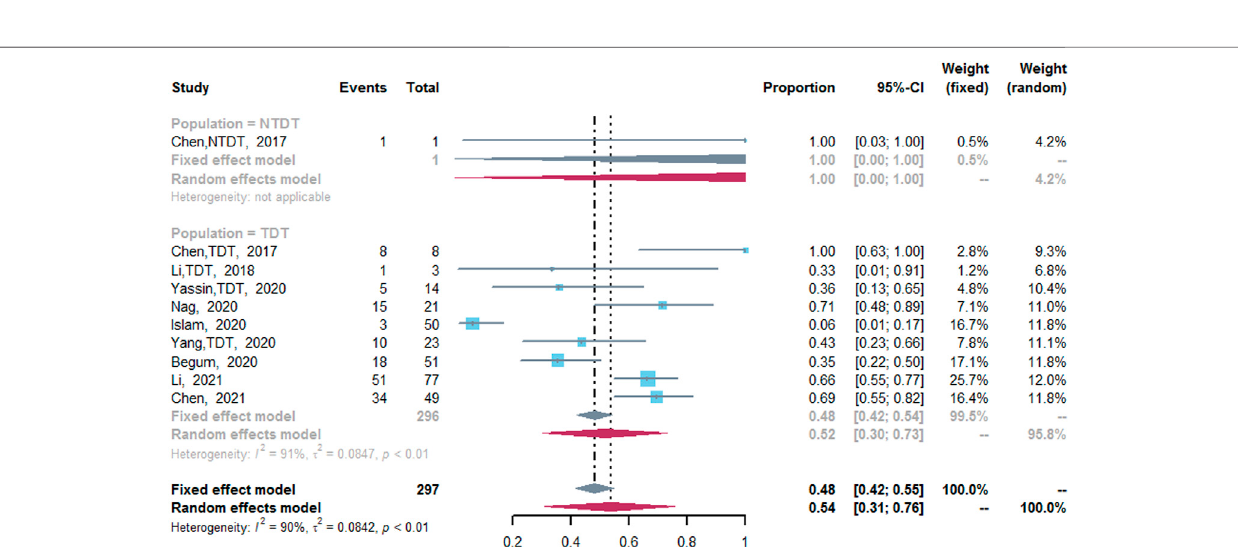
FIGURE 3 | A forest plot illustrating complete response rate in population-based subgroups.